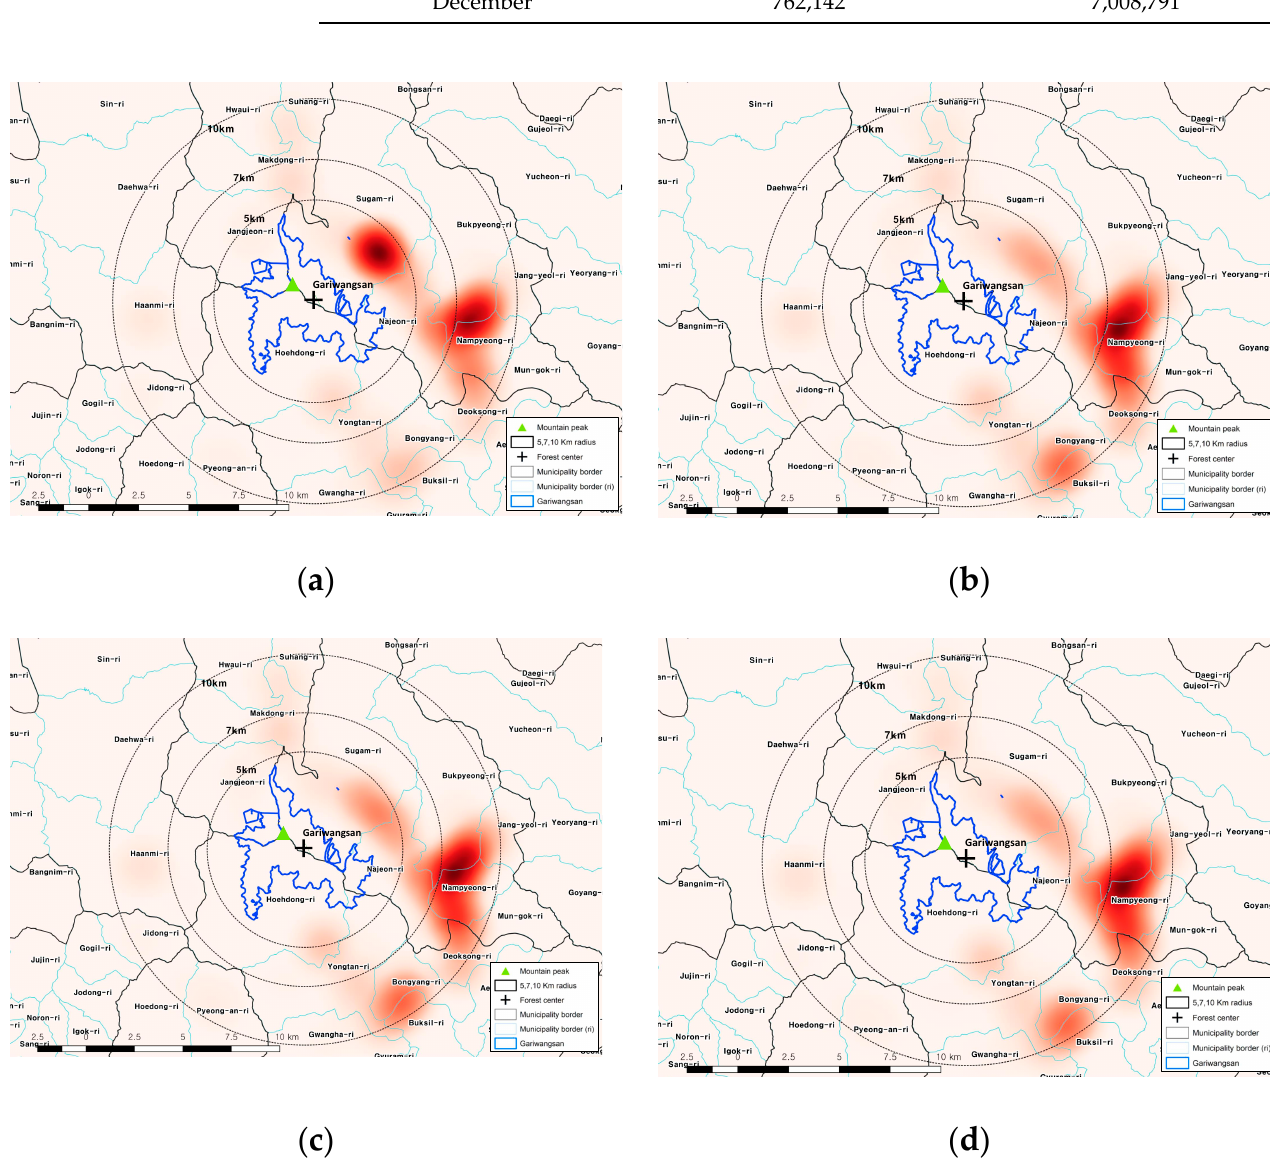
Figure 13. Spatial distribution of the demand intensity of Gariwangsan in ( a ) March, ( b ) June, ( c ) September, and ( d ) December 2019.